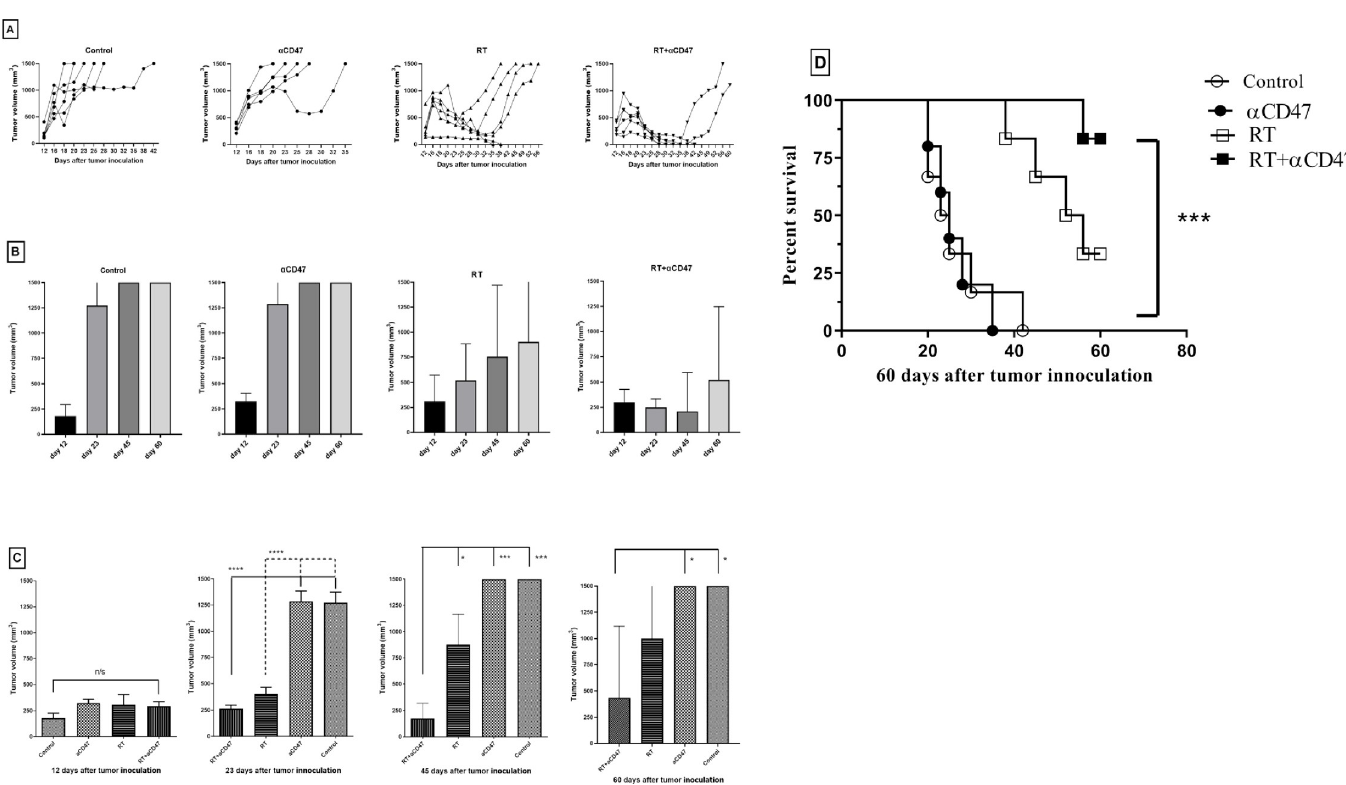
Fig 6. Combining RT and α CD47 reduced tumor volume and increased survival rates. The tumor size change for all the groups during the study is shown (A). The average tumor volume for each group at 12, 23, 45, and 60 days after induction of the tumor is shown (B). The differences between the average tumor volume in groups at 12, 23, 45, and 60 days after induction of the tumor are shown. Tumor volumes averaged at the start of the study 100–300 mm 3 and there was no significant difference between groups (C). Data are displayed as means (SD) and were analyzed using the Tukey’s Multiple Comparison Test ( � : P < 0.05, ��� : P < 0.001, and ���� : P < 0.0001). Survival of the tumor-bearing mice is shown in (D). Survival data were analyzed using the Log-rank (Mantel-Cox) Test ( ��� : P < 0.001).